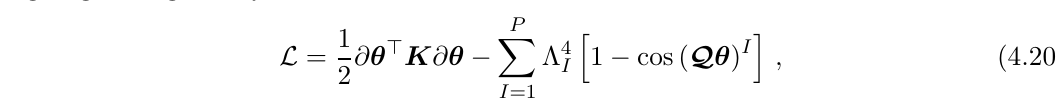
for kinetic alignment in the original model where P = N; T p N relative to f max